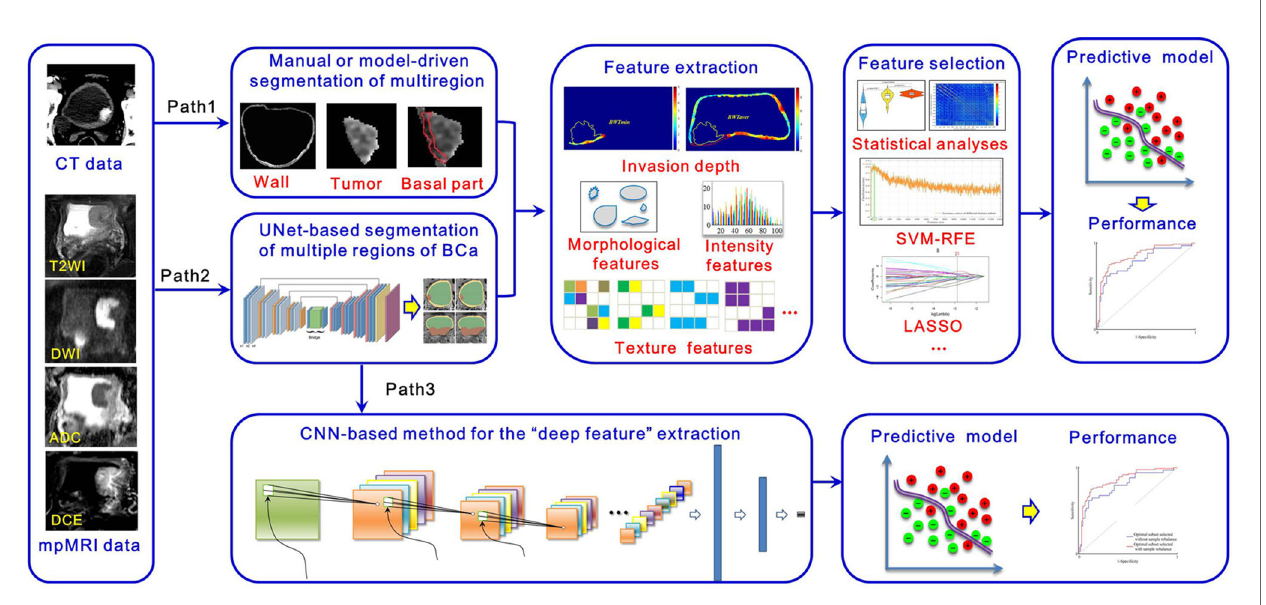
FIGURE 2 | Overall work fl ow of the radiomics strategy for decoding BCa phenotype and recurrence